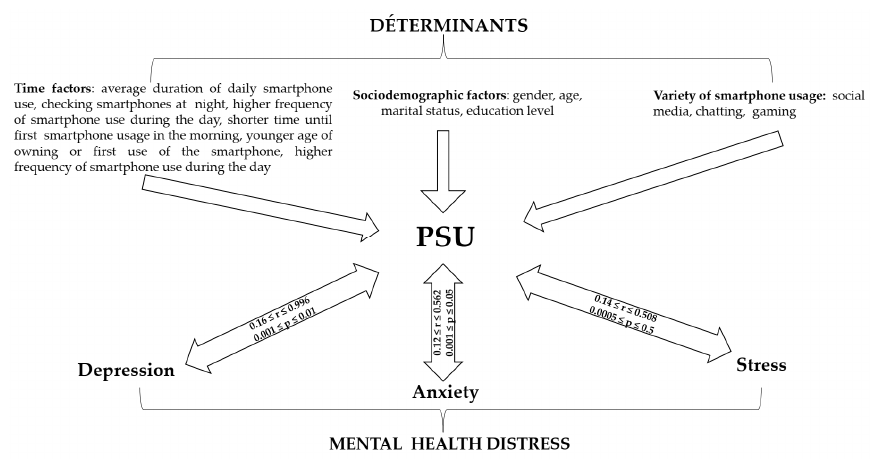
Figure 2. Relationships between PSU, its determinants, and mental health. r/Correlation coefficient and p / p -value.